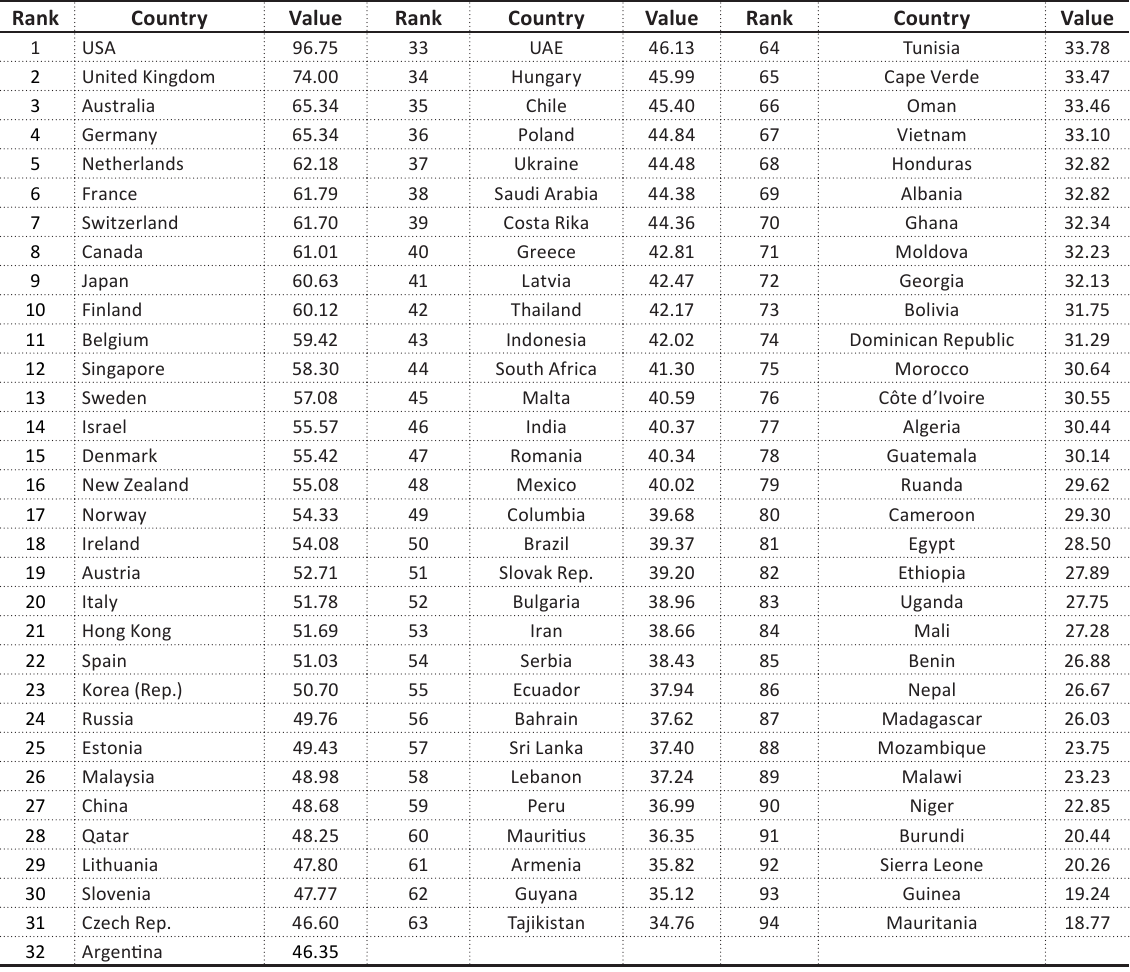
Table 1. The national higher education systems’ competitiveness index